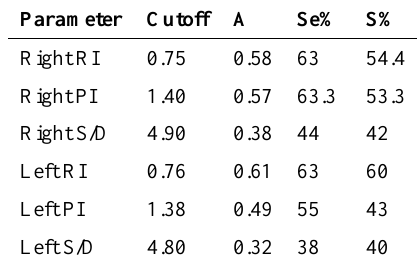
Table 4: Coordinates of the ROC Curve of Doppler parameters for prediction of hydatidiform mole in early